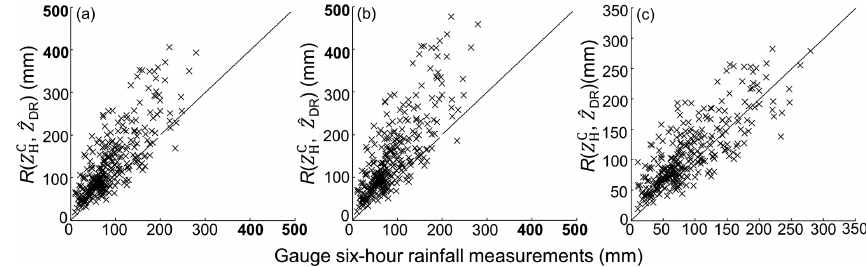
, ˆ Z DR ) versus corresponding gauge rainfall measurements at 22:00UTC, H